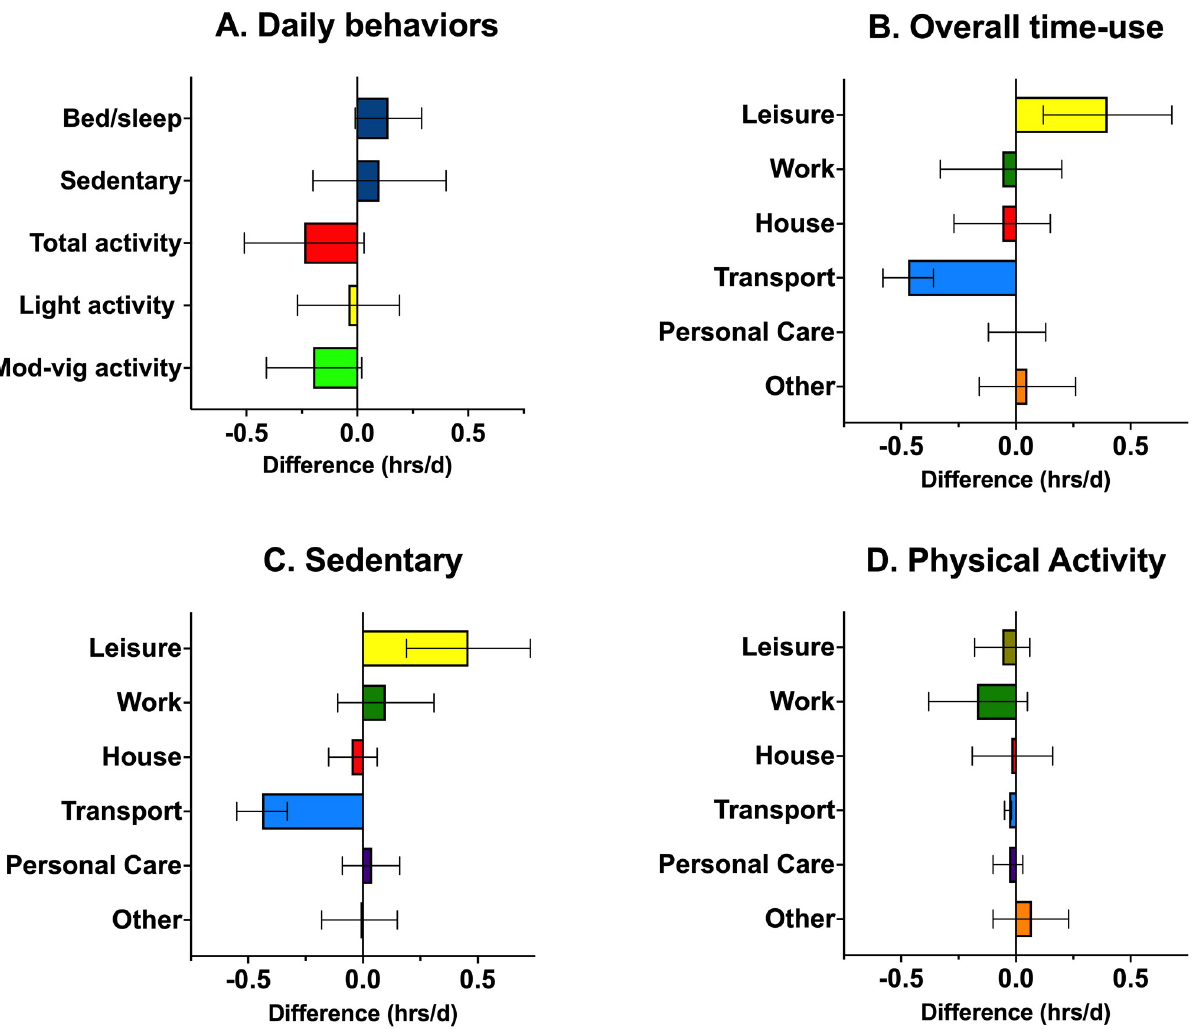
Fig 1. Mean differences (95%CIs) between Fall 2019 and Fall 2020 in daily behaviors, overall time-use in the waking day, sedentary behavior, and physical activity. The Other category is composed of Categories with a low prevalence of reporting (Church or spiritual pursuits; Volunteer; School/ education; Private time; Unreported (gap)